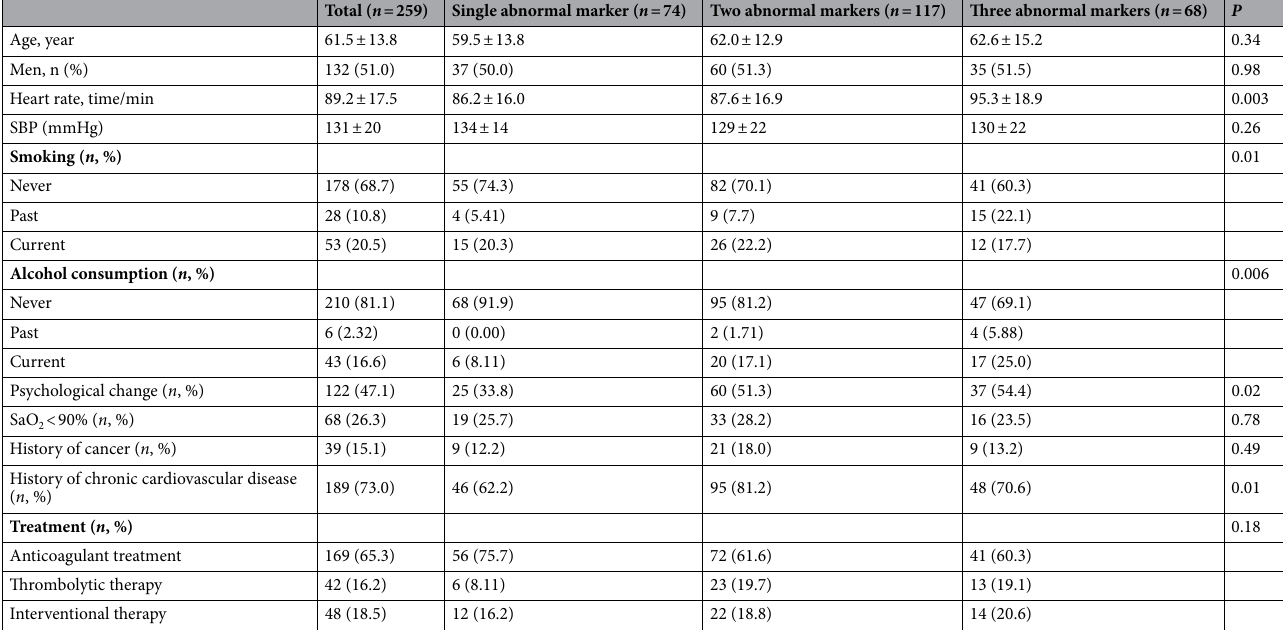
Table 1. Baseline characteristics of newly-diagnosed acute pulmonary embolism patients. SBP, systolic blood pressure; SaO 2 , blood oxygen saturation.